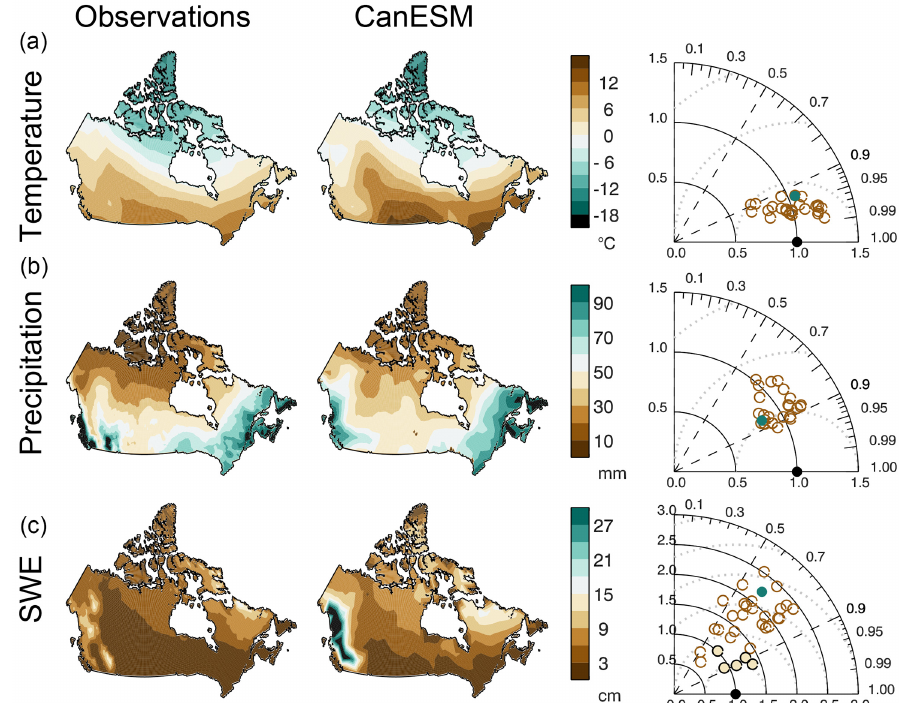
Figure 2. As in Fig. 1, for April–June